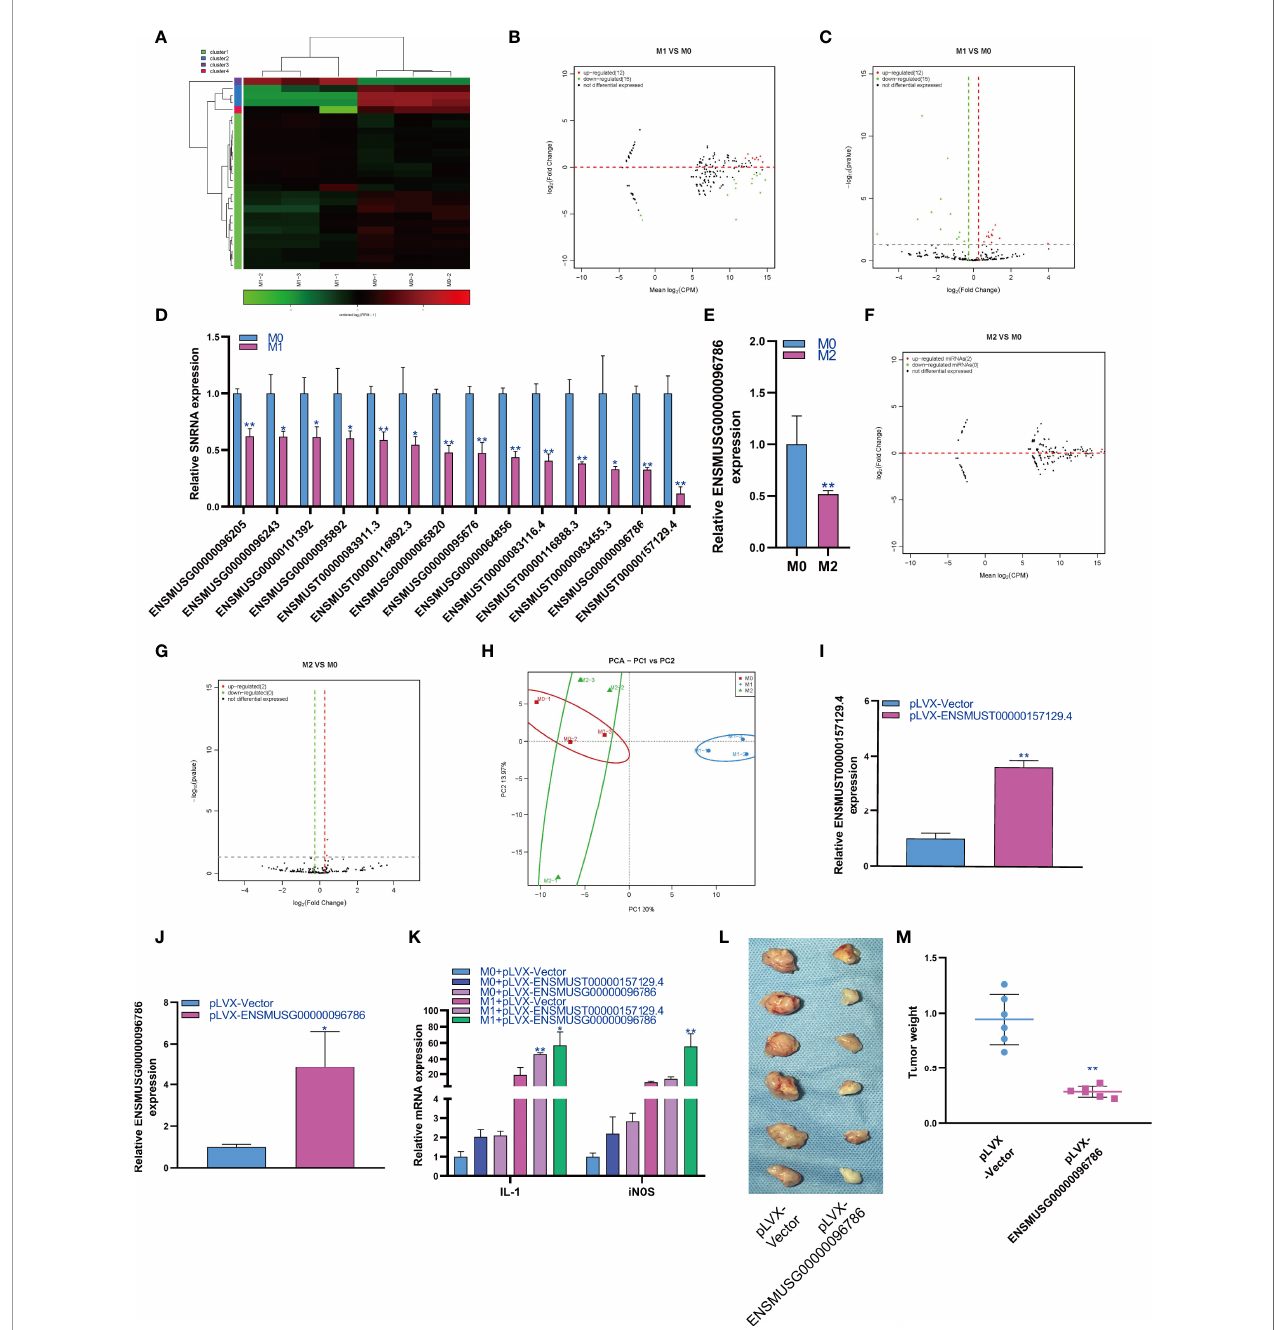
FIGURE 4 | Changes in snRNA expression during macrophage polarization. Hotmap (A) , MA (B) and volcano plot (C) show the small RNA sequencing results of the expression of snRNA in M0 and M1 macrophages. (D) The expression of snRNA in M1 macrophages as detected by qPCR. (E) The expression of snRNA in M2 macrophages as detected by qPCR. MA (F) and volcano (G) show the small RNA sequencing results of the expression of snRNA in M0 and M2 macrophages. (H) PCA of snRNA expression in M0, M1 and M2 macrophages. * indicates p < 0.05 compared to M0, and ** indicates p < 0.01 compared to M0. (I) The expression of snRNA ENSMUST00000157129.4 in RAW264.7 cells transfected with pLVX-Vector or pLVX- ENSMUST00000157129.4 were detected by qPCR. (J) The expression of snRNA ENSMUSG00000096786 in RAW264.7 cells transfected with pLVX-Vector or pLVX- ENSMUSG00000096786 were detected by qPCR. (K) The expression of IL-1 and iNOS in RAW264.7 cells were detected by qPCR, * indicates p < 0.05 and ** indicates p < 0.01 compared to M1+ pLVX-Vector group. (L) Photographs showed the size of the tumor in mouse injected with RAW264.7 cells with pLVX-Vector or pLVX- ENSMUSG00000096786. (M) Tumor weight in mouse injected with RAW264.7 cells with pLVX-Vector or pLVX- ENSMUSG00000096786, ** indicates p < 0.01 compared to pLVX-Vector